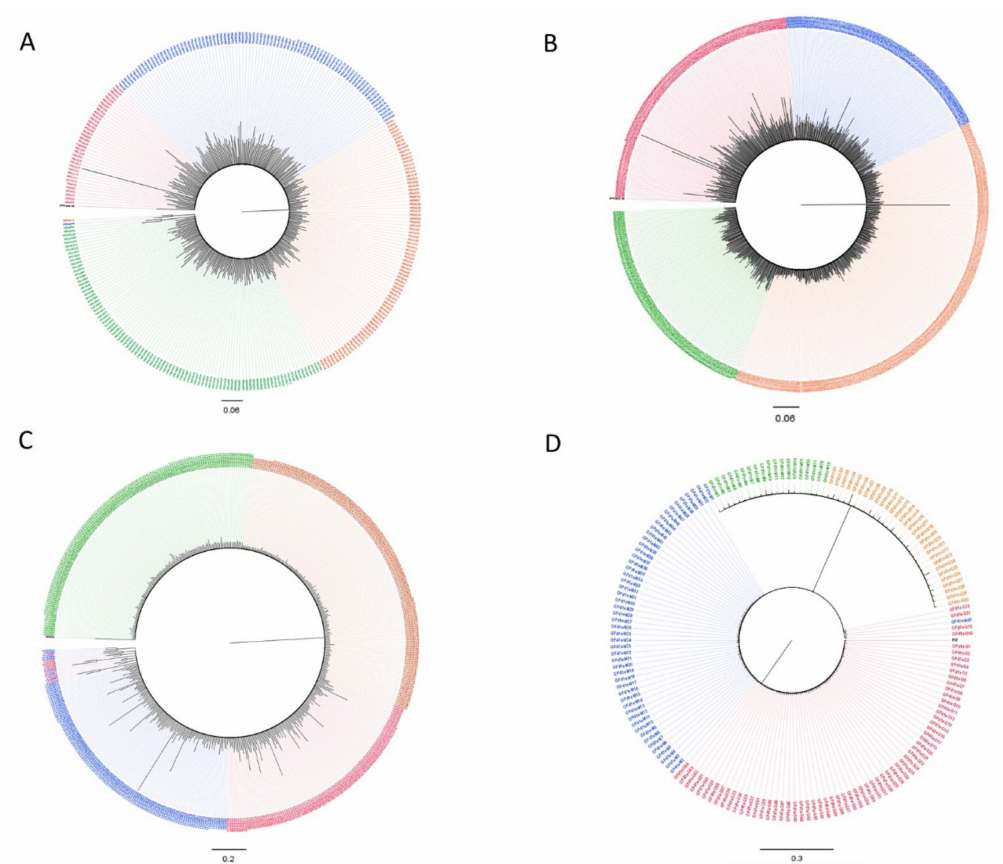
Figure 3. Bayesian trees for quasispecies of the HIV protease ( A ), RT ( B ), V1V2 ( C ) and gp41 ( D ) regions from the male (G) and female (M) partners of the couple based on the analyses of whole-blood samples obtained before the start of therapy (orange and green color for G and M, respectively) and during treatment (red and blue color for G and M,